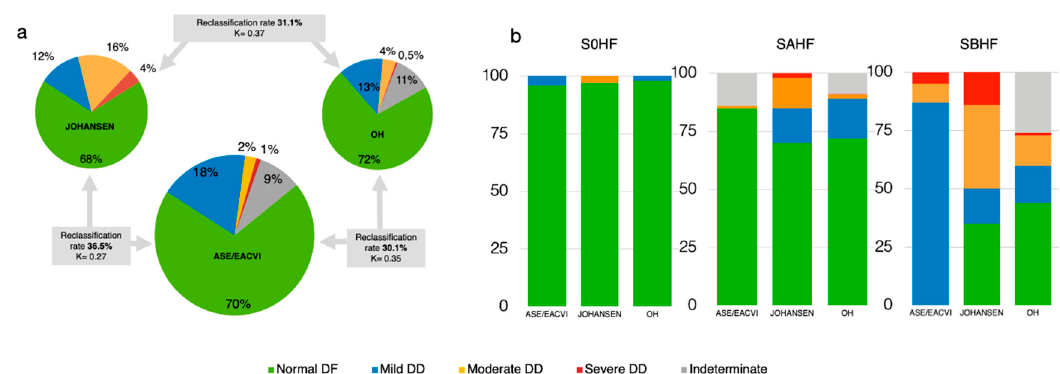
Figure 3. Frequency of different grades of diastolic dysfunction per each algorithm. ( a ) Central pie describes prevalence of different grade of diastolic function based on ASE/EACVI, while, on upper left and right, those for JOAHNSEN and OH are reported, respectively. Reclassification rate and Kappa coefficients are depicted for each comparison. ( b ) Prevalence of grades of diastolic dysfunction per clinical stages, for each method, are represented as pile histograms. Abbreviations: S0HF, Stage 0